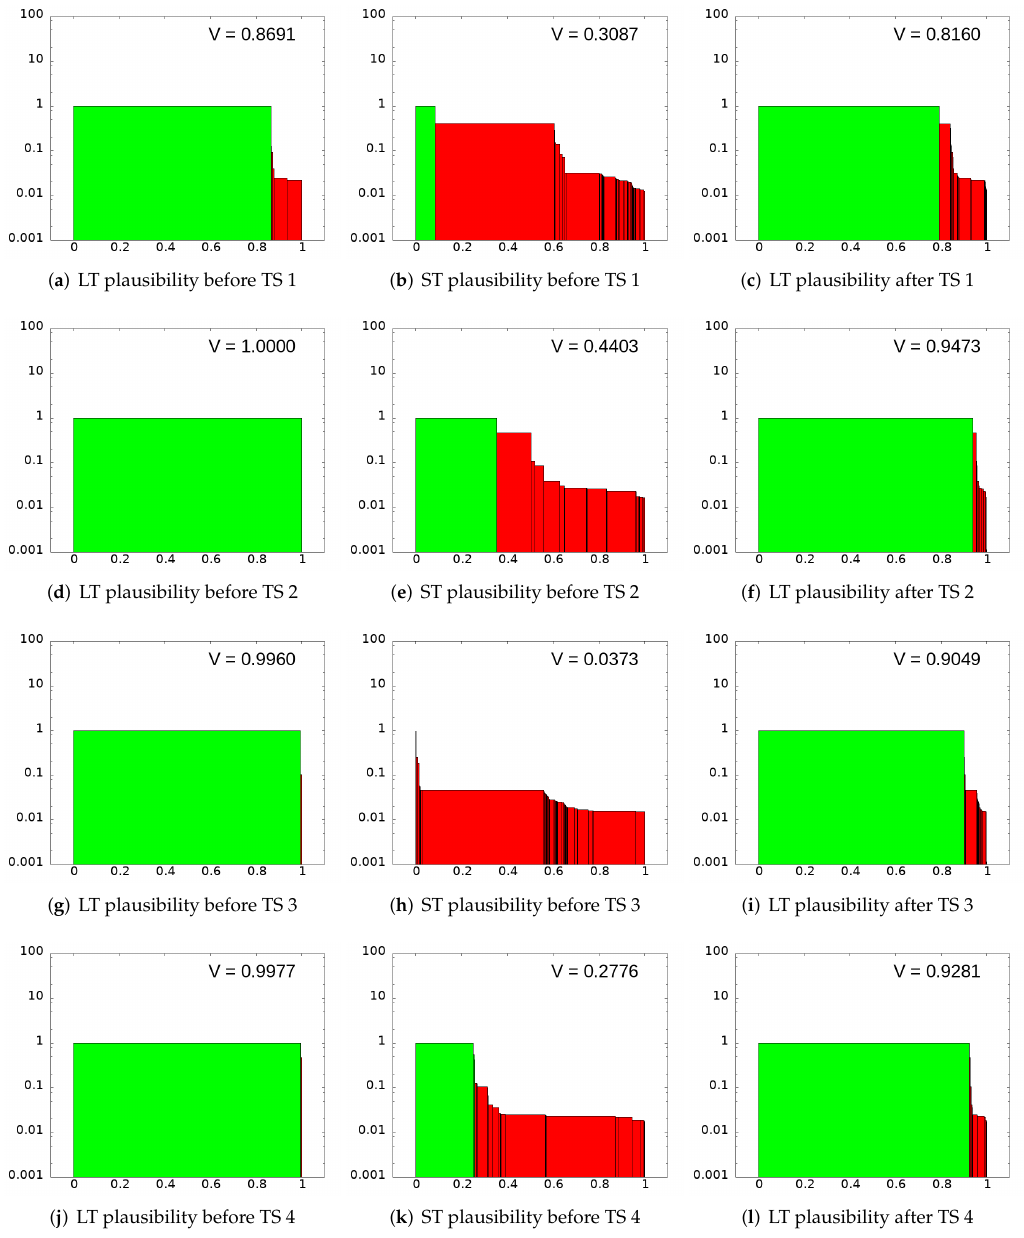
Figure 5. State of particle filters during the first four resetting conditions (timestamp or TS’s). It can be observed that the robustness of the procedure remains on